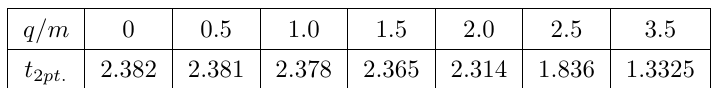
Table 9 . Example thermalization times of 2-point functions of charged scalar operators, t 2 pt: , in a magnetic thermalizing (cid:13)uid (dual to the evolution towards a magnetic black brane geometry) (cid:26) = 0, B = 1. The thermalization times are determined according to the measure de(cid:12)ned in eq. (4.2). The p length of separation considered is l = 0 : 7 2